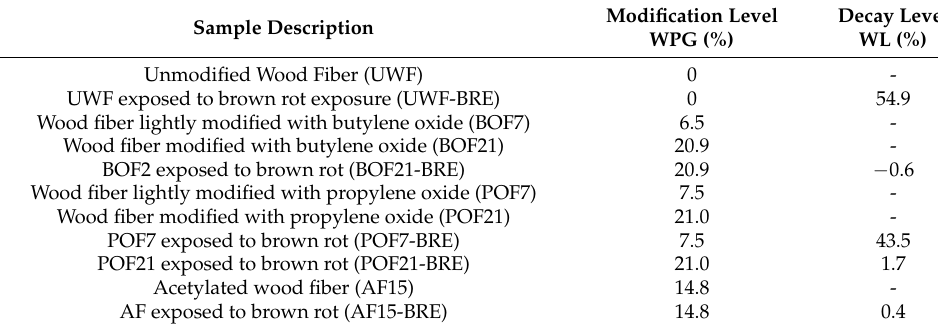
Table 4. Description of samples studied using